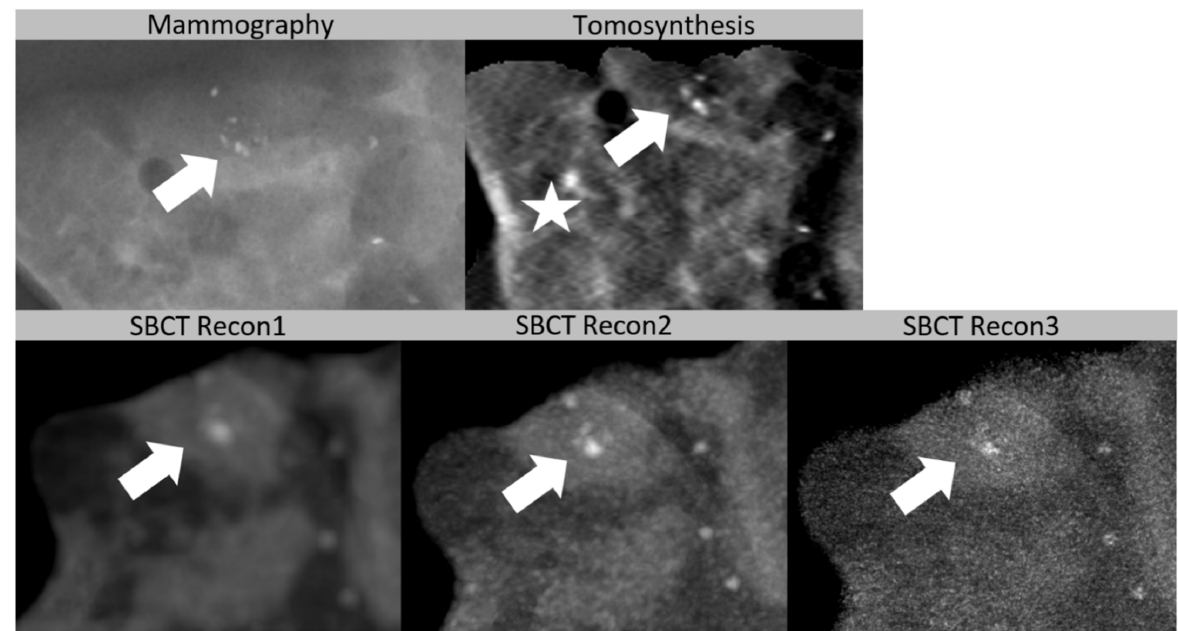
Figure 5. Cluster of microcalcifications in a biopsy specimen of a 58-year-old patient. Histopathology was benign (sclerosing adenosis). The cluster (arrow) can be clearly recognized in spiral breast computed tomography (SBCT) and in tomosynthesis. In this case, differentiation was best with Recon2 (voxel size (0.05 mm) 3 , smooth kernel), compared to tomosynthesis and Recon1 (voxel size (0.15 mm) 3 , smooth kernel) or Recon3 (voxel size (0.05 mm) 3 , sharp kernel). Diffuse microcalcifications are clearly visible with tomosynthesis and SBCT. Tomosynthesis shows a possibly false positive microcalcification (star).